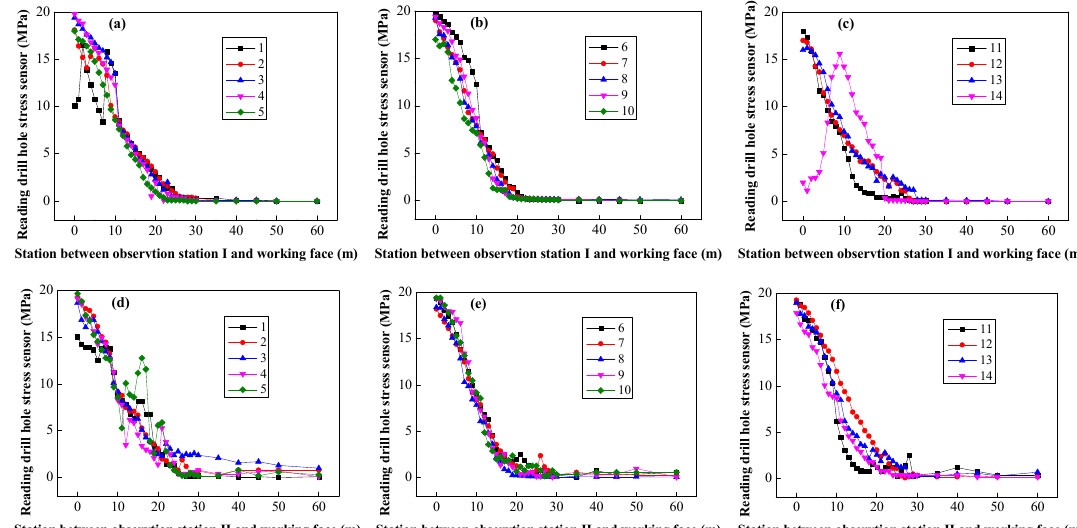
Figure 12. Relation curve between the distance from the measuring station to the working face and the borehole stress reading. ( a ) Relation curve between the distance from I# station to the working face and the stress sensor of 1#~5# borehole; ( b ) Relation curve between the distance from I# station to the working face and the stress sensor of 6#~10# borehole; ( c ) Relation curve between the distance from I# station to the working face and the stress sensor of 11#~14# borehole; ( d ) Relation curve between the distance from II# station to the working face and the stress sensor of 1#~5# borehole; ( e ) Relation curve between the distance from II# station to the working face and the stress sensor of 6#~10# borehole; ( f ) Relation curve between the distance from II# station to the working face and the stress sensor of 11#~14#